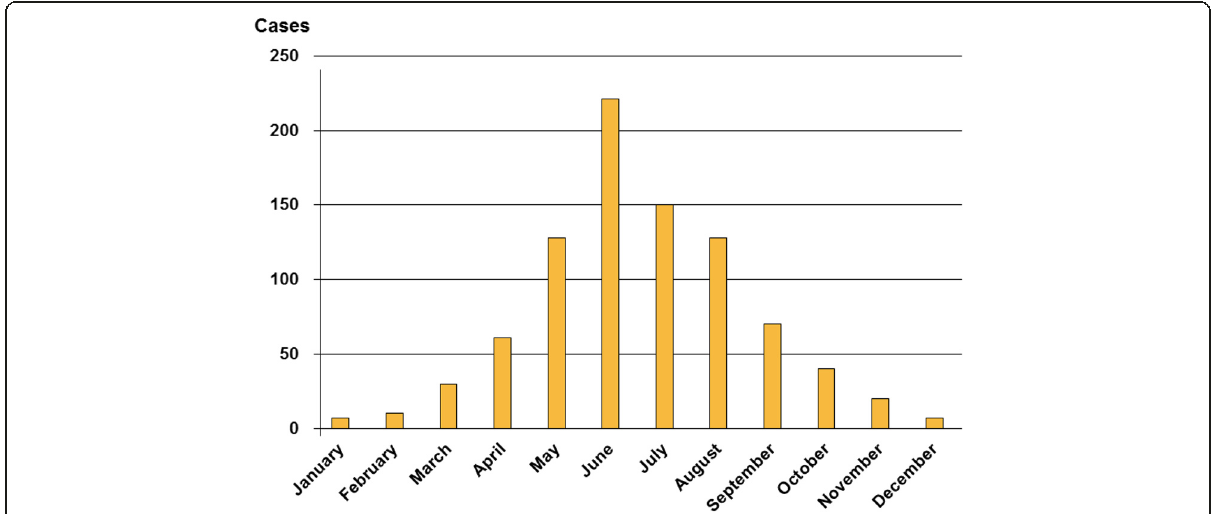
Fig. 2 Monthly distribution of snakebites (data from CAPM, 2009-2013)